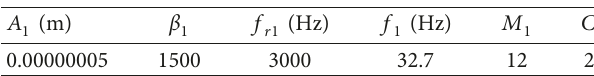
Figure 15: Results obtained by EEMD: (a) first IMF; (b) envelope spectra of the first IMF. Table 4: Simulation parameters in the first IRS. Table 5: Simulation parameters in the second